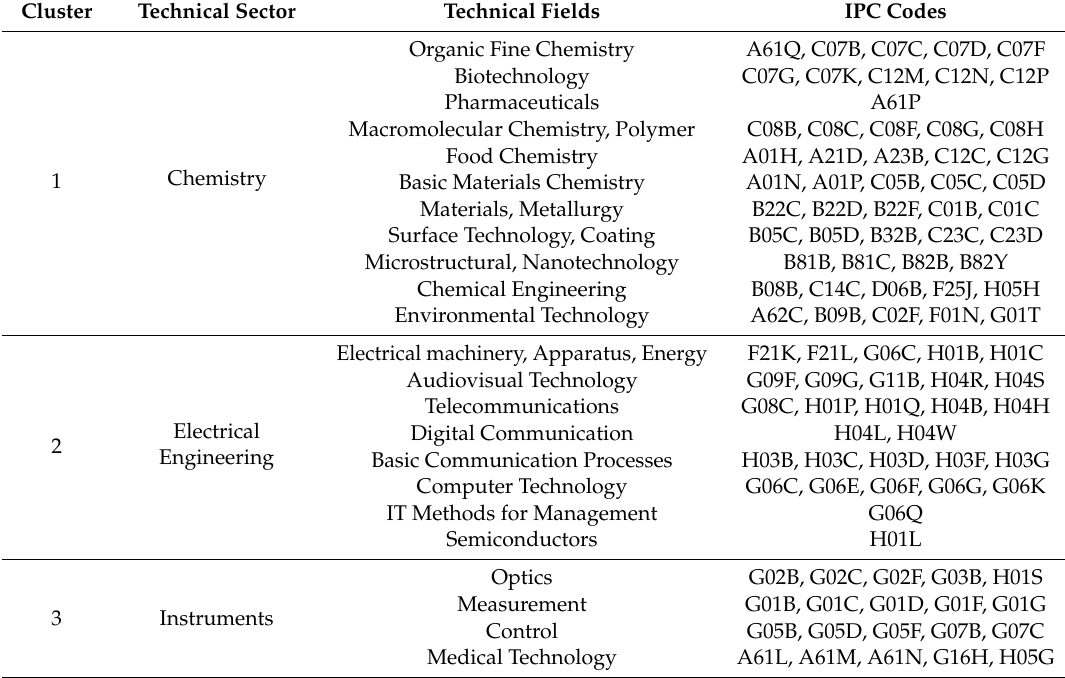
Table 4. Results of patent